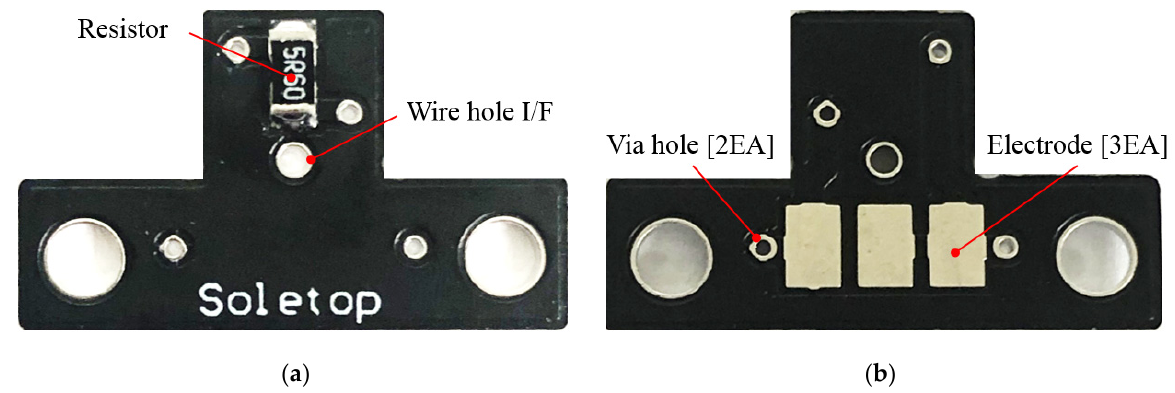
Figure 7. Mechanical configuration of the burn resistor PCB: ( a ) front view and ( b ) rear view.